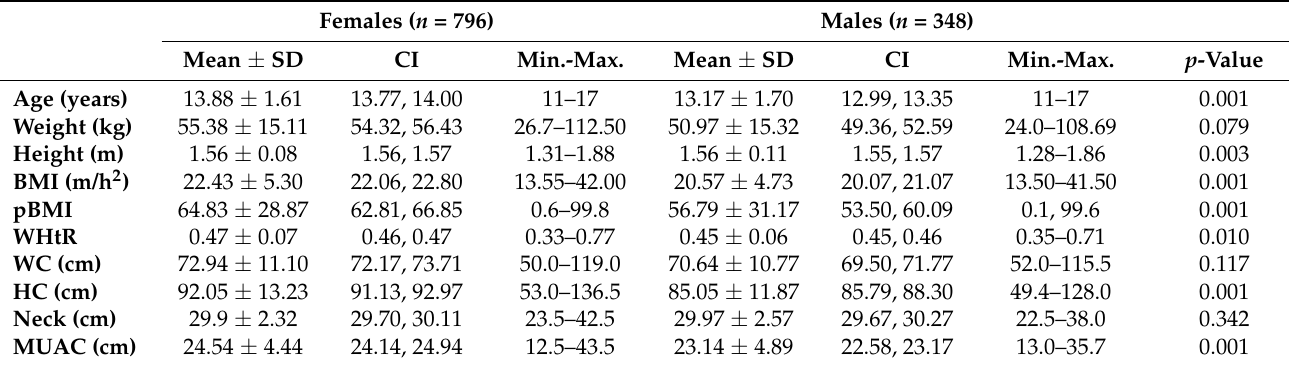
Table 1. Baseline characteristics of the study population.